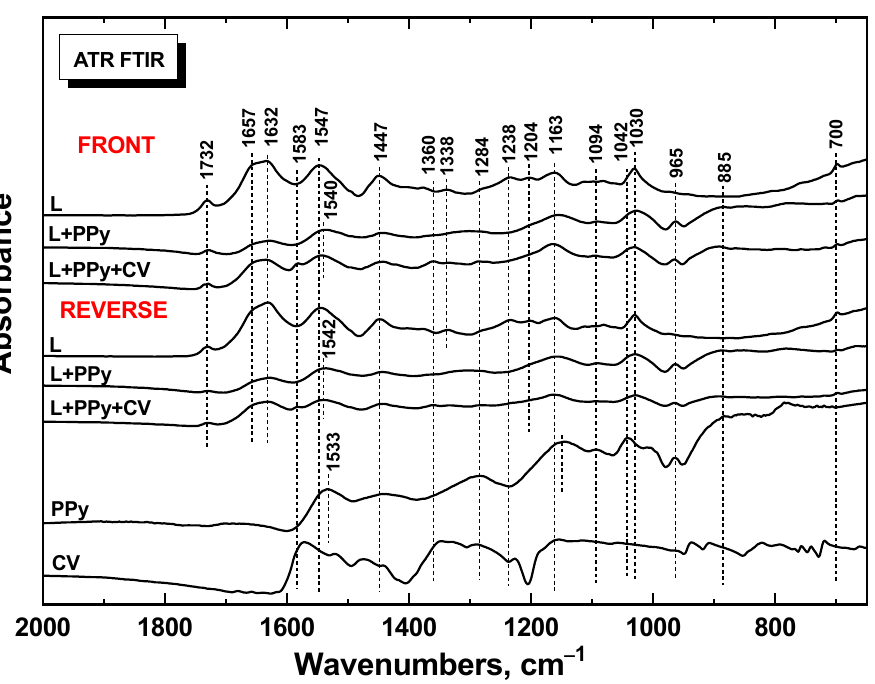
Figure 7. ATR FTIR spectra of original (L) and polypyrrole-coated leather (L + PPy) in the absence or presence of crystal violet (CV) recorded from the front and reverse sides. Table 3. Mechanical properties of the original leather and the leather coated with polypyrrole in the presence of poly( N -vinylpyrrolidone) and crystal